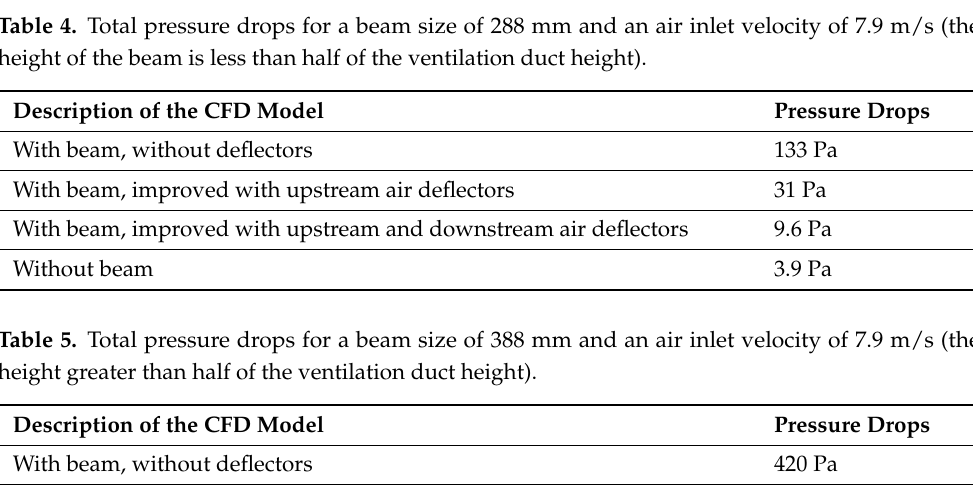
Figure 11. Air velocity; cross sections for the measuring areas T1, T2, and T0 (outlet located at 6 m downstream of the beam); CFD model with a beam size of 288 mm.